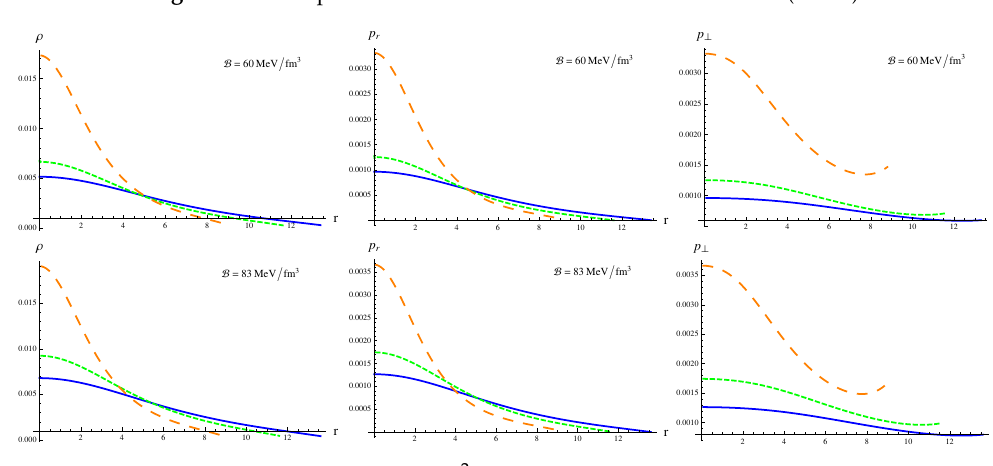
Figure 2. Matter variables (in km − 2 ) as functions of r (in km) with m Ψ = 0.001.